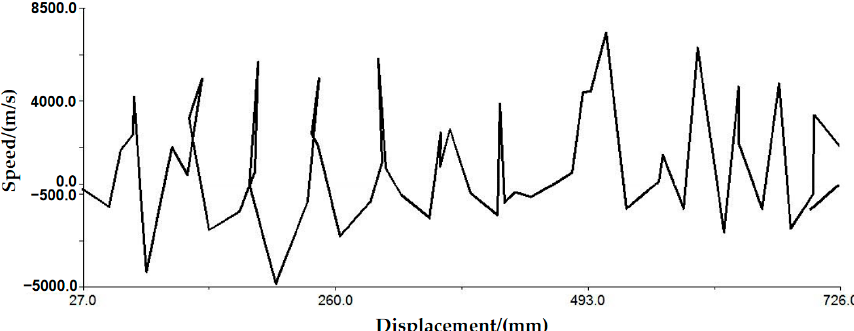
Figure 15. Velocity of link_1 in y-direction vs, displacement in the y-direction.